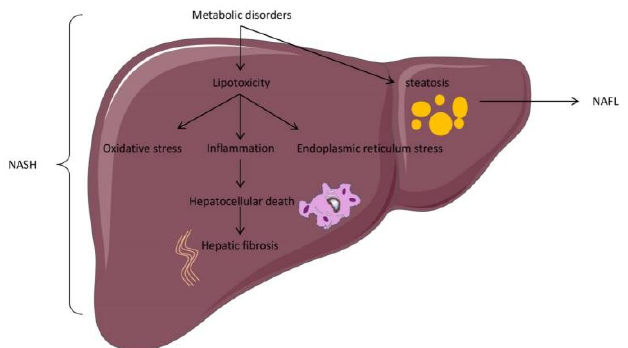
Figure 2. Basic pathological changes in an NAFLD model